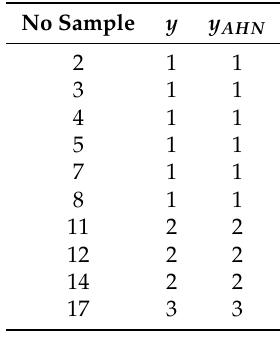
Table A5. Comparison between estimated y AHN and target y values for the numerical example. No